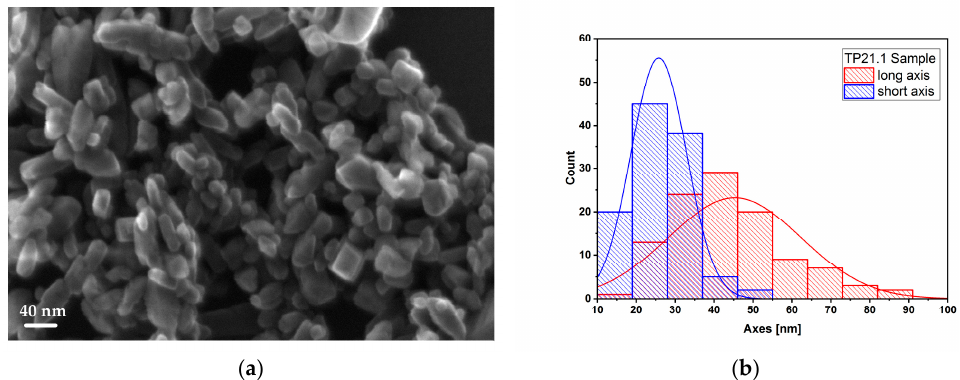
Figure 9. SEM image of TP21.1 sample ( a ) and histogram ( b ) representing the dimensional distribu- tion of NPs.